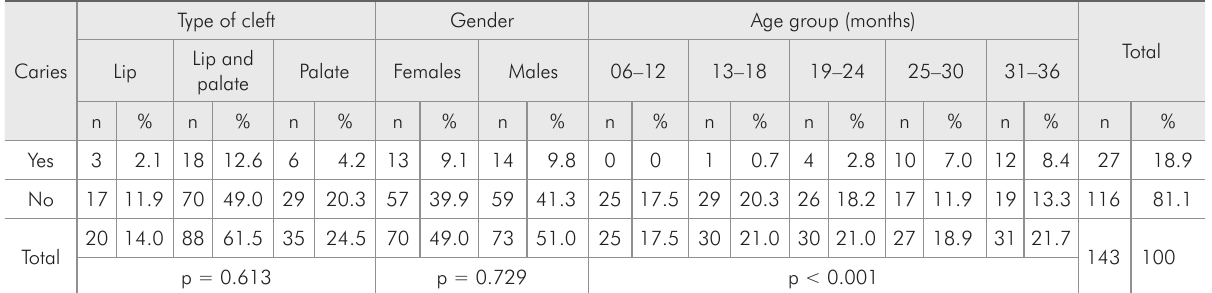
Table 2 - Correlation between dental caries and cleft type, gender and age group expressed in absolute numbers and percent-